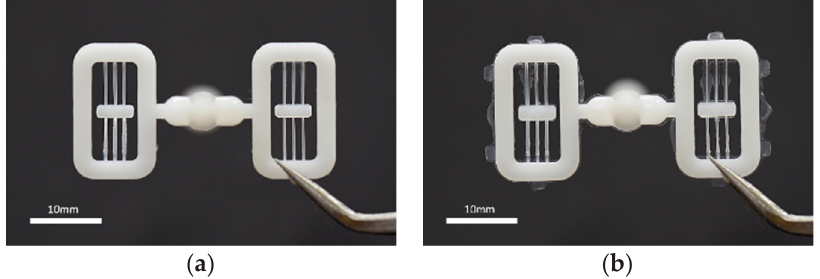
Figure 9. Molded V-beam structures in good quality ( a ) and with flashes ( b ).